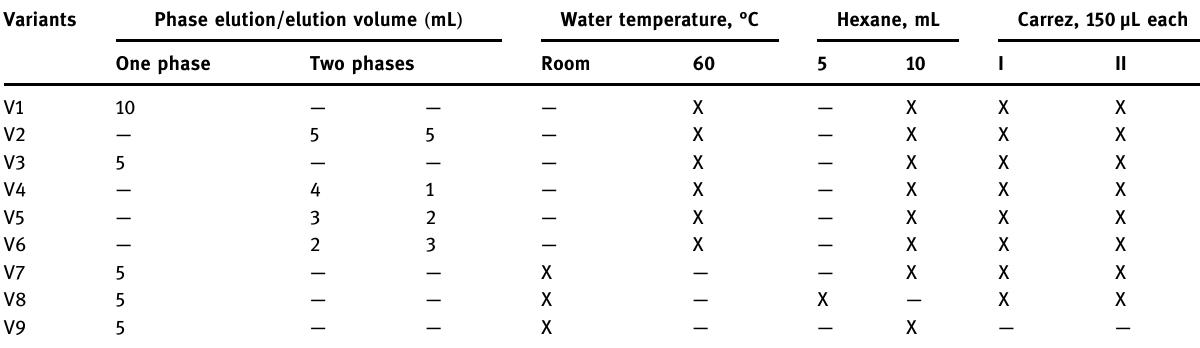
Table 1: Experimental variants with the working conditions of SPE clean - up procedure